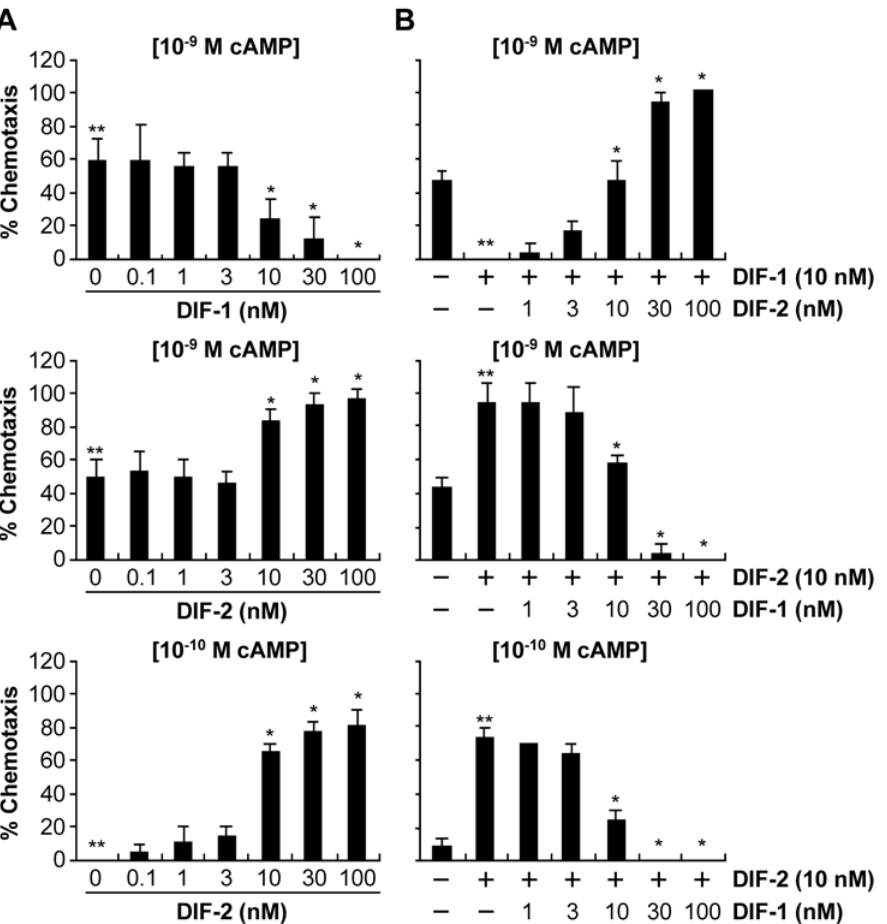
Figure 3. Dose and combined effects of DIF-1 and DIF-2 on chemotaxis in HM1030 ( dmtA - ). (A) Effects of DIF concentrations on chemotaxis. HM1030 cells starved for 6 h were spotted on PB agar containing 3 mM caffeine plus various concentrations of DIF-1 ( top ) or DIF-2 ( middle and bottom ) and assayed for chemotaxis toward the doses of cAMP indicated in square brackets. Data are the mean and s.d. (bars) of three independent experiments (n=3). (B) Combined effects of DIF-1 and DIF-2 on chemotaxis. HM1030 cells starved for 6 h were spotted on PB agar containing 3 mM caffeine plus 10 nM DIF-1 in combination with the various concentrations of DIF-2 ( top ) or plus 10 nM DIF-2 in combination with the various concentrations of DIF-1 ( middle and bottom ) and assayed for chemotaxis toward the doses of cAMP indicated in square brackets. Data are the mean and s.d. (bars) of three independent experiments (n=3). * P , 0.05, as compared with **Control.